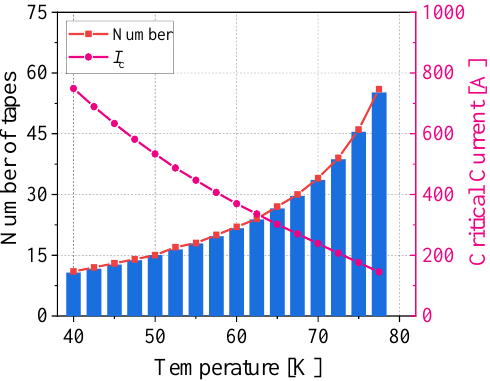
Figure 4. Quantity of PA1212 2G HTS tapes required in different temperature.